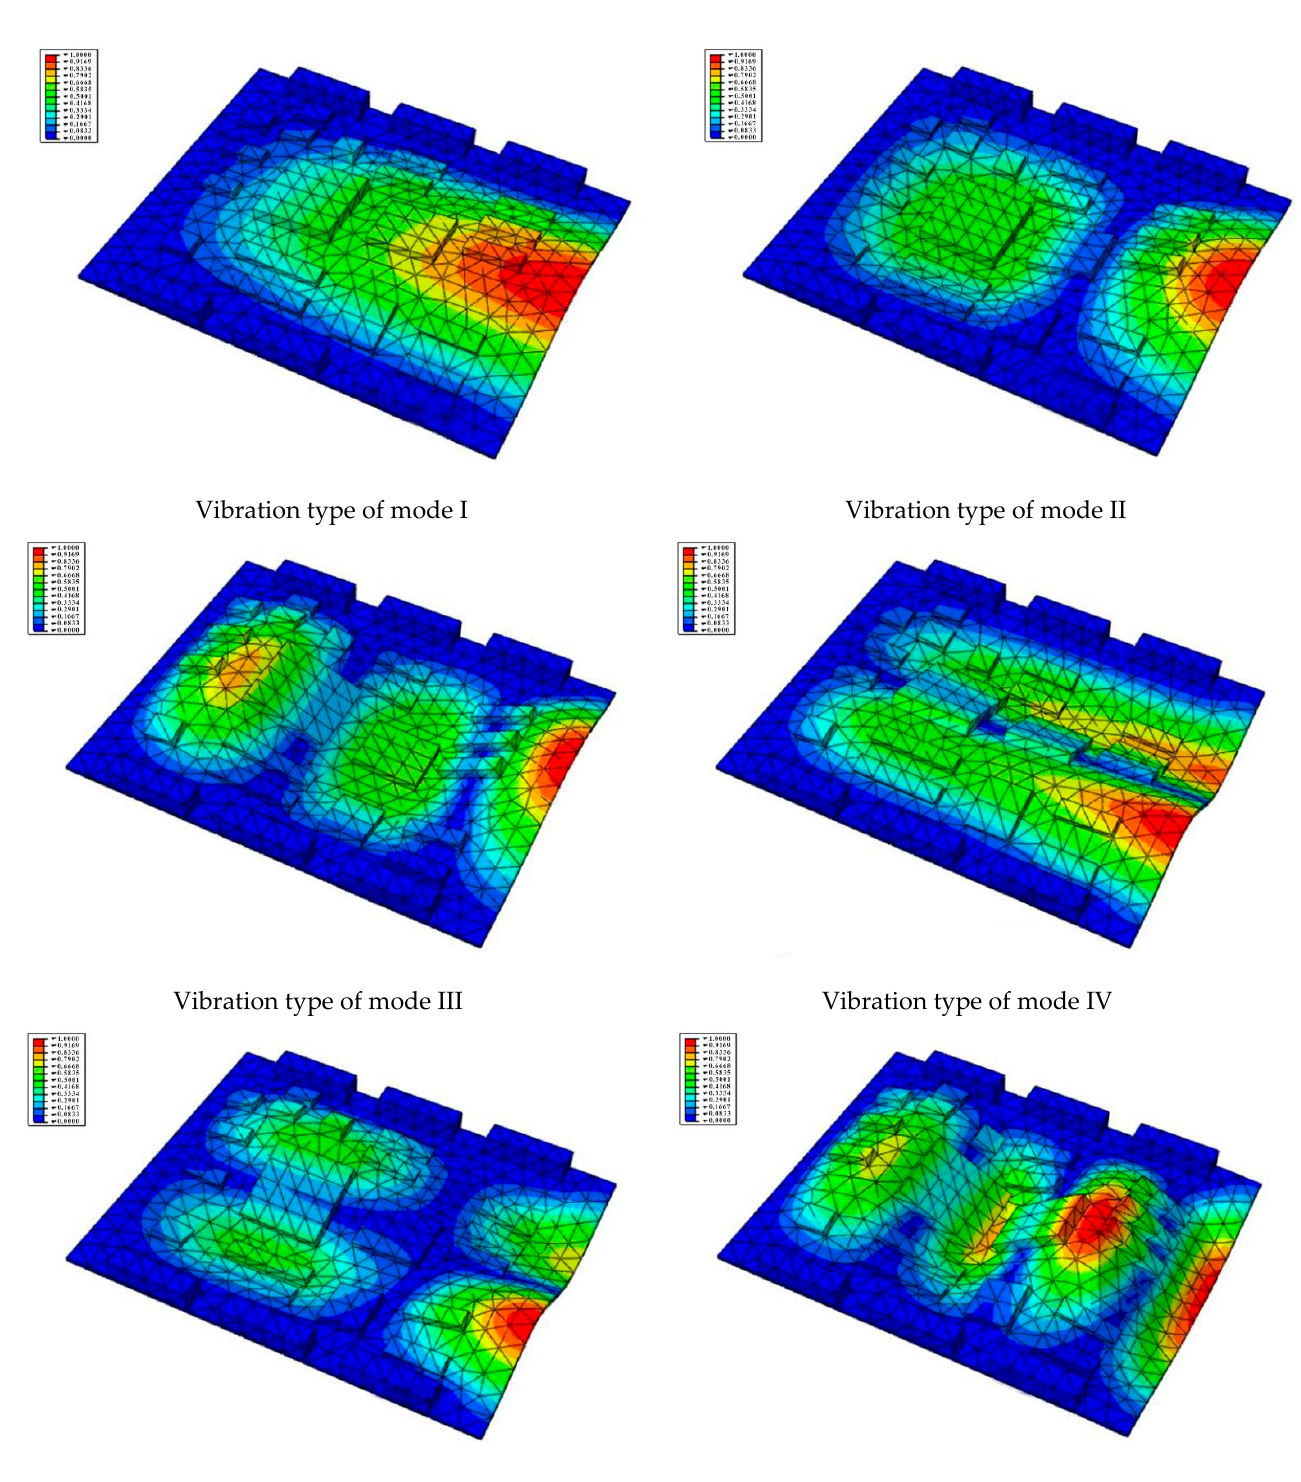
Figure 11. The first six vibration types of CPU board after optimization.